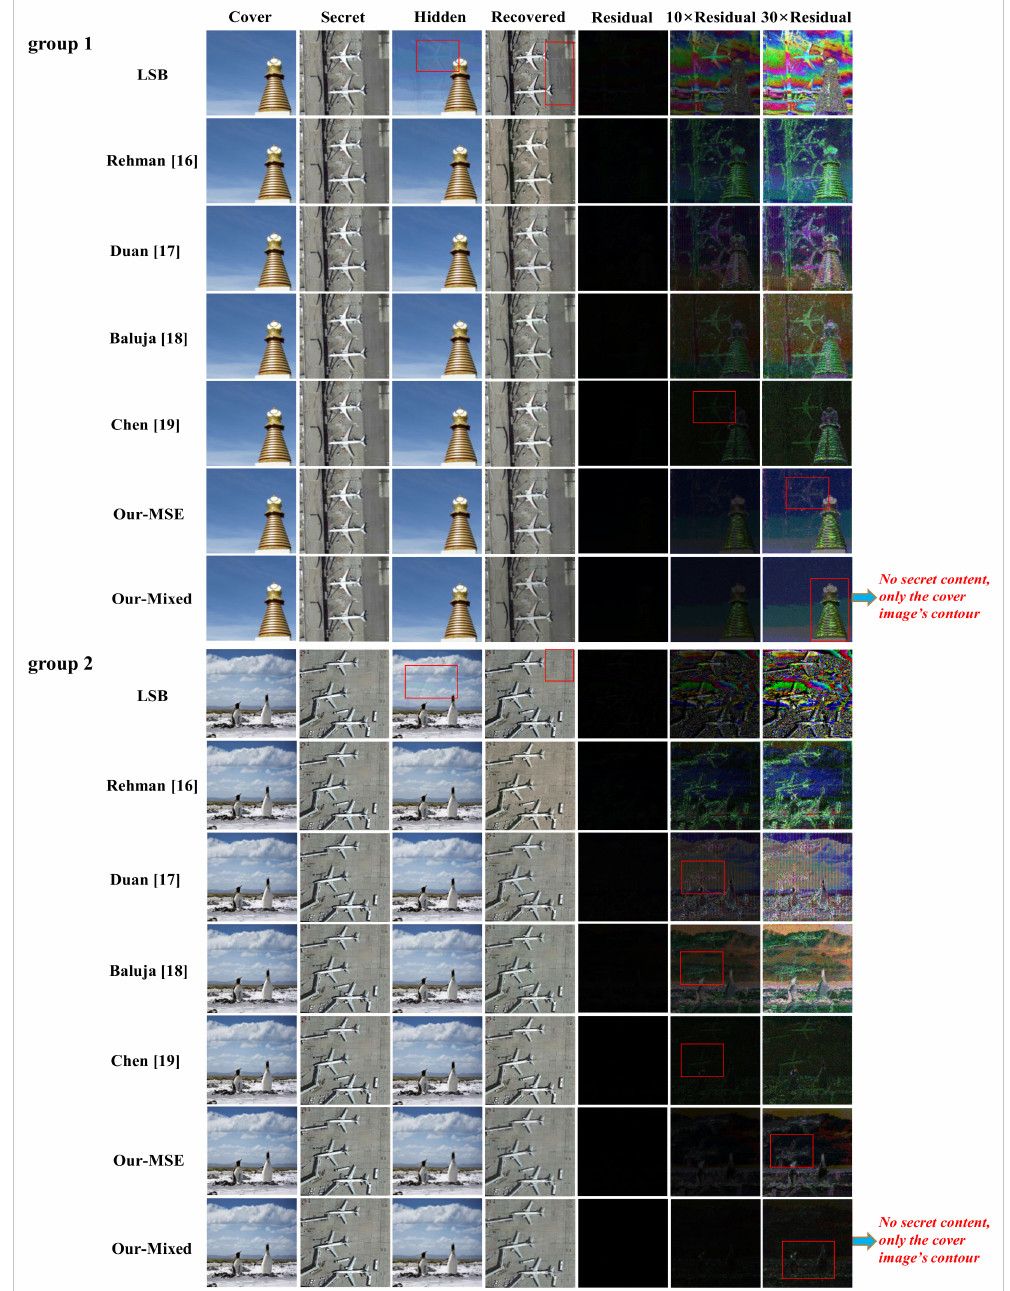
Figure 5. Visual performance of different